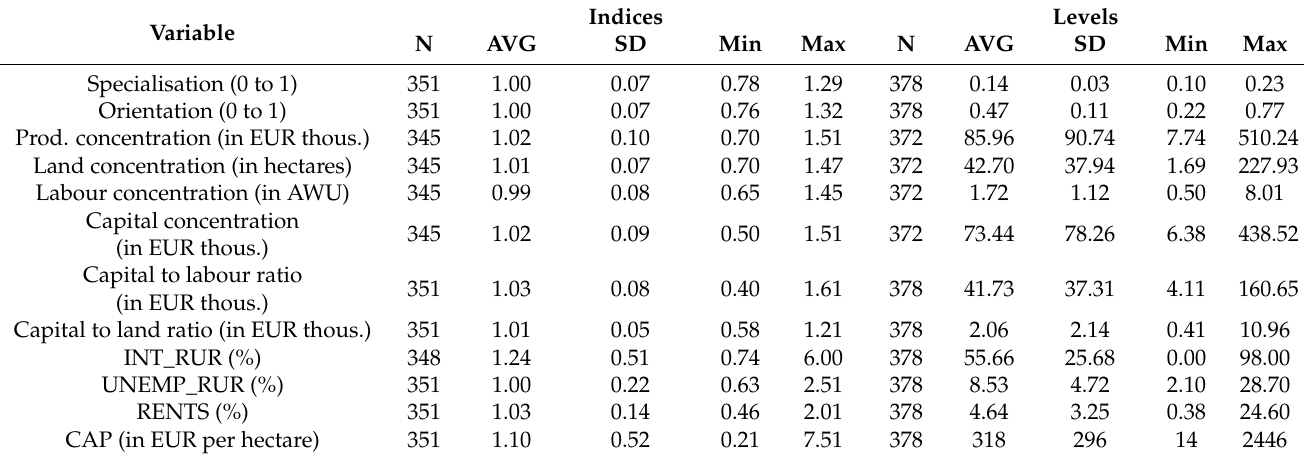
Table 1. Descriptive statistics of the variables used in the panel logit